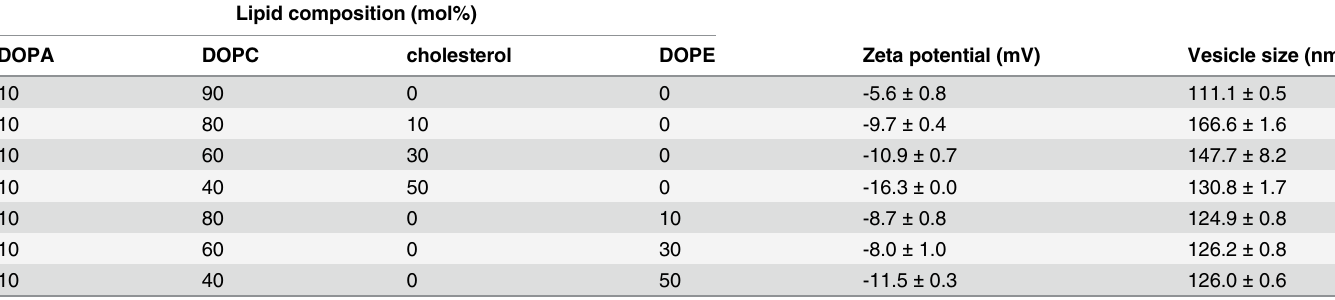
Table 1. Zeta potential and size of